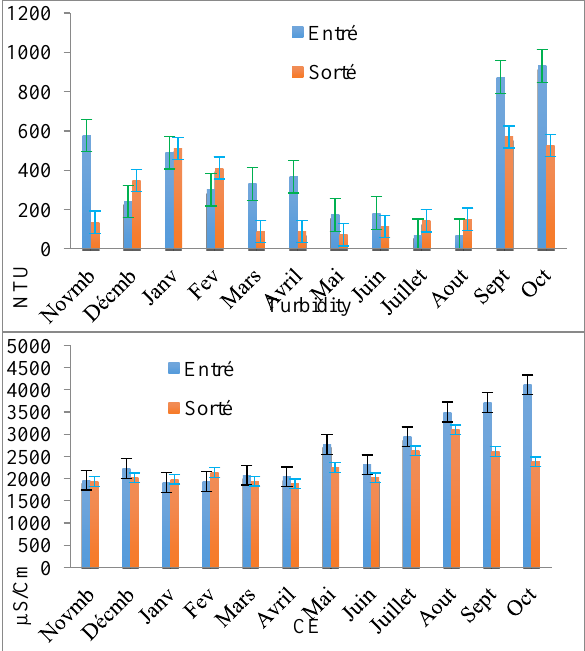
Figure 3. Change in the values of the CE and NTU at the entrance and exit of the